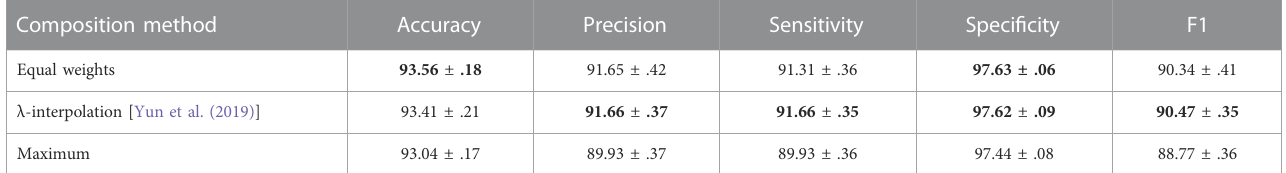
TABLE 3 Ablation study of composition methods. Equal weights mean that the overlapping area of I p and I c are combined half and half. λ shows that we sampled a λ from beta distribution and then applied linear interpolations in the overlapping areas of two images. The fi nal maximum experiment represents the operation of taking the maximum pixel value in overlapping